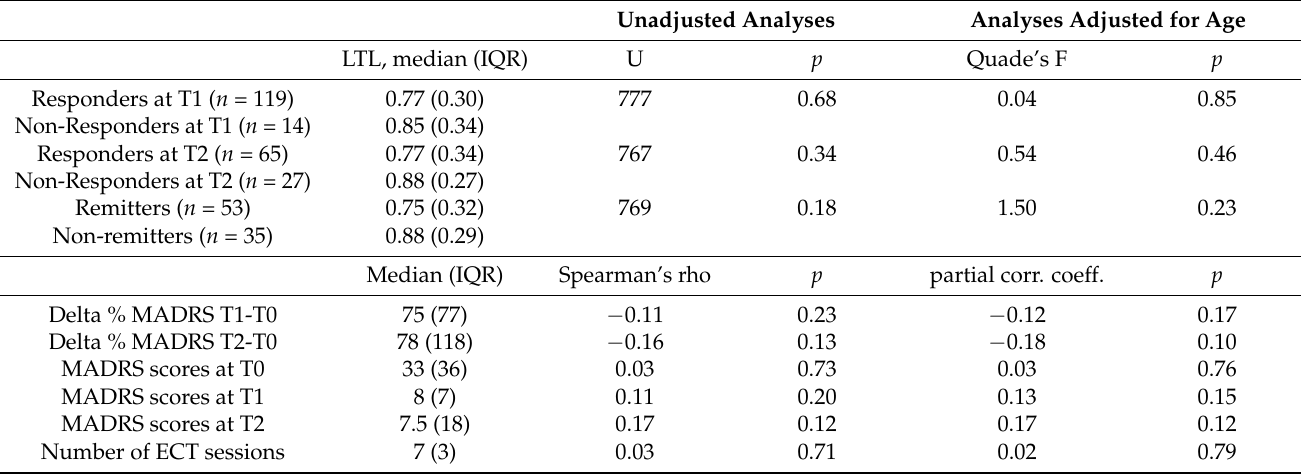
Table 3. Comparison of baseline LTL in relation to ECT response.